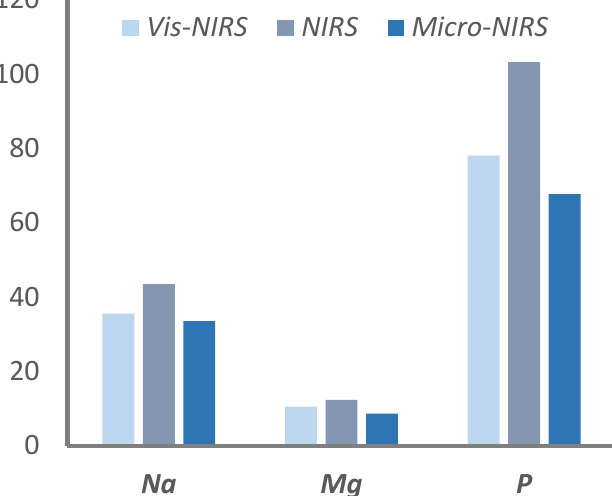
Figure 3. Average of absolute errors of prediction (in mg / kg of meat) obtained from external validation for the minerals presenting significantly di ff erent levels of precision with the three infrared